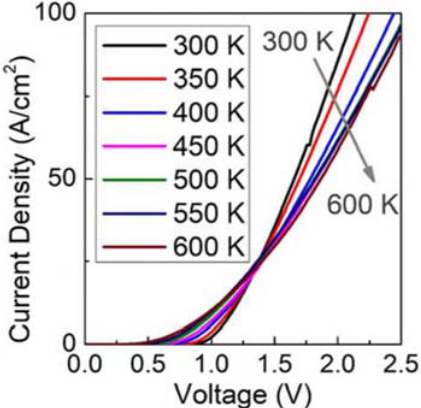
Figure 7. Impact of the temperature on the forward characteristics of β -Ga 2 O 3 SBD. Reprinted from [110], with the permission of AIP Publishing.